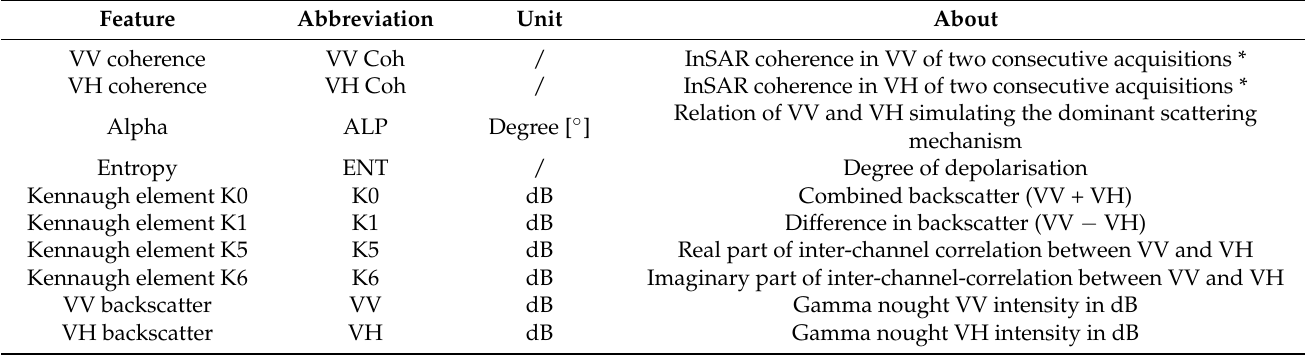
Table 2. Computed Sentinel-1 features, their abbreviations, units, and interpretation. Dimensionless features are labelled as such by “/” in the column